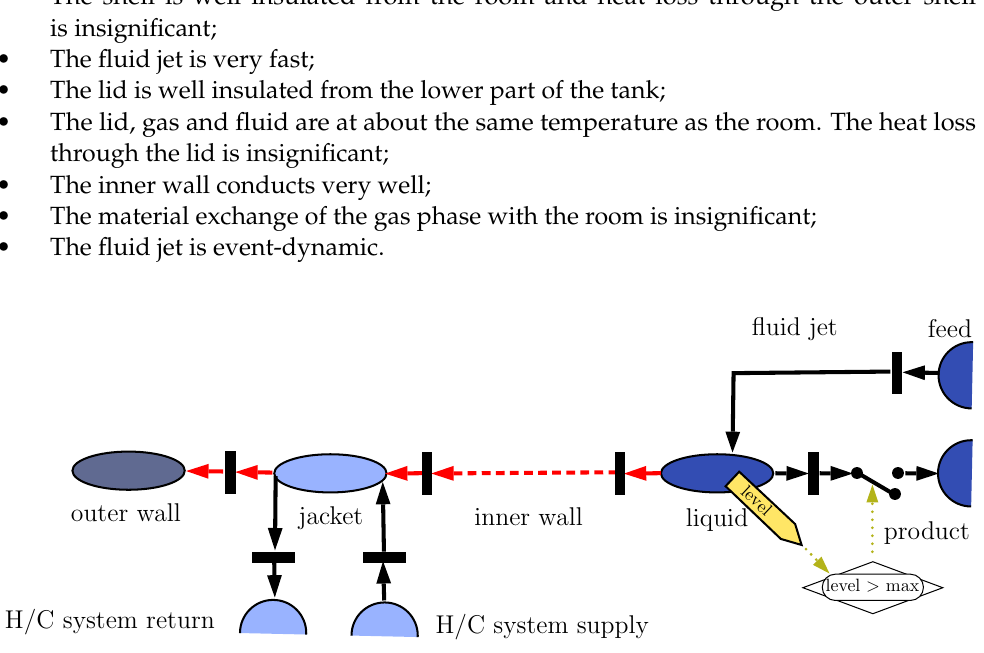
Figure 9. A simplified tank model. No heat loss through the outer shell, lid and gas phase; “breathing” is neglected, jet is event-dynamic.